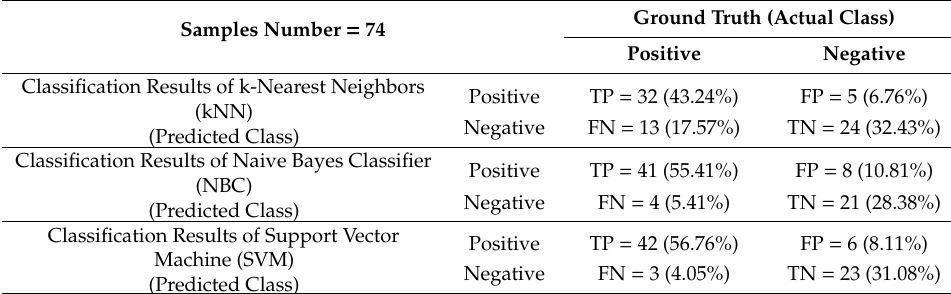
Table 3. The confusion matrix of assessing